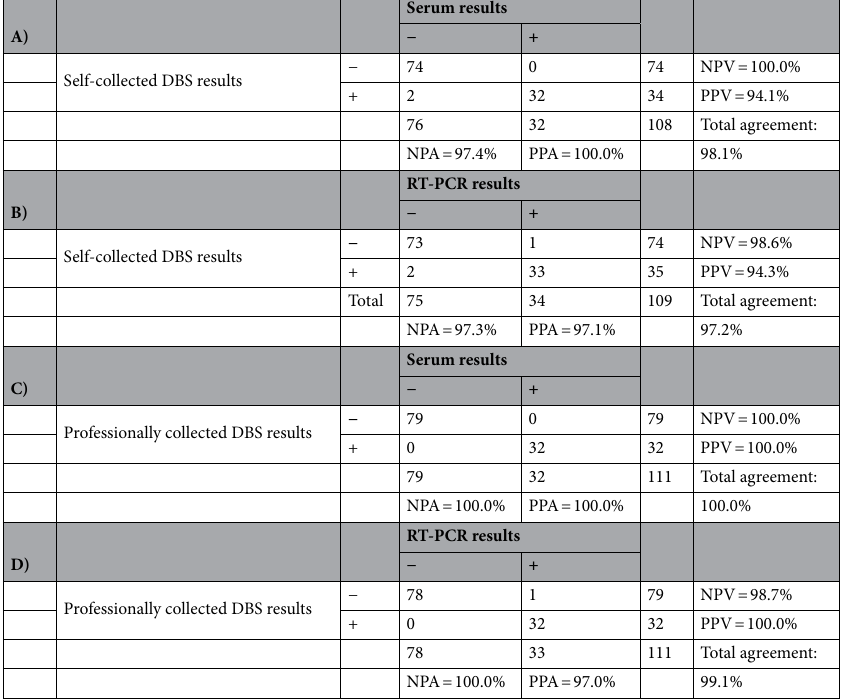
(Fig. 2B,D). Total qualitative categorical agreement (n = 111) to venous serum results was 100.0% (Table 3C). When compared to RT-PCR results, qualitative categorical agreement was 99.1% with an NPA and PPA of 100.0%